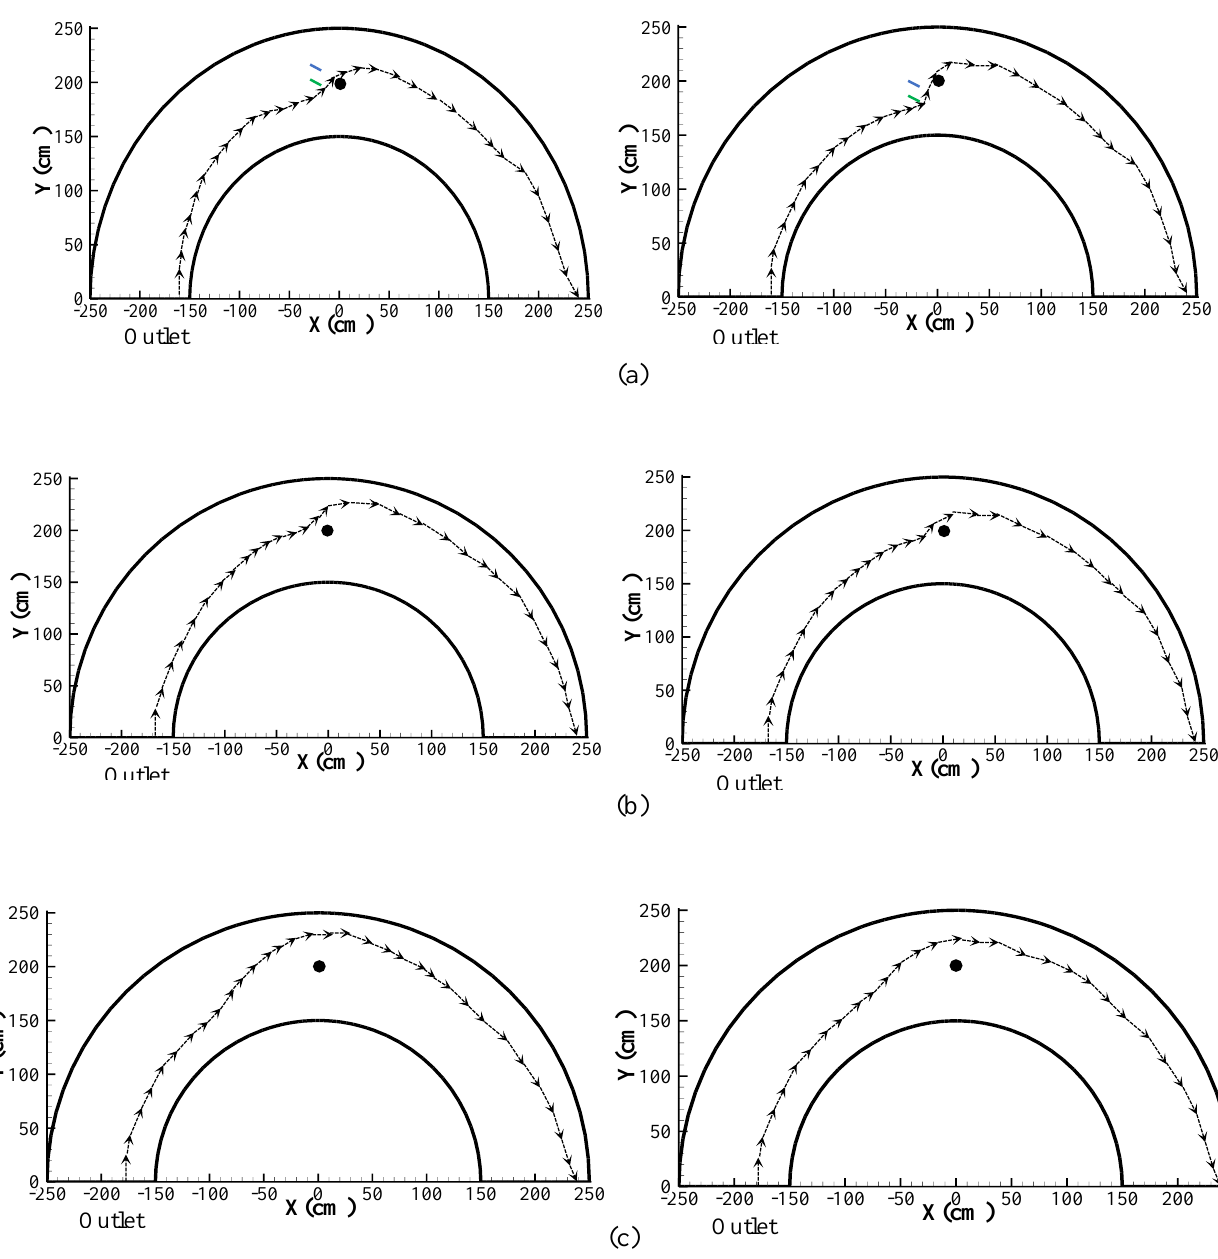
Figure 8. The path to formation of the maximum resultant velocity at the levels equal to a) 5, and b) 55% of the flow depth from the bed, and c) 5% of the flow depth from water surface (PFV experiment on the right, and PSV experiment on the